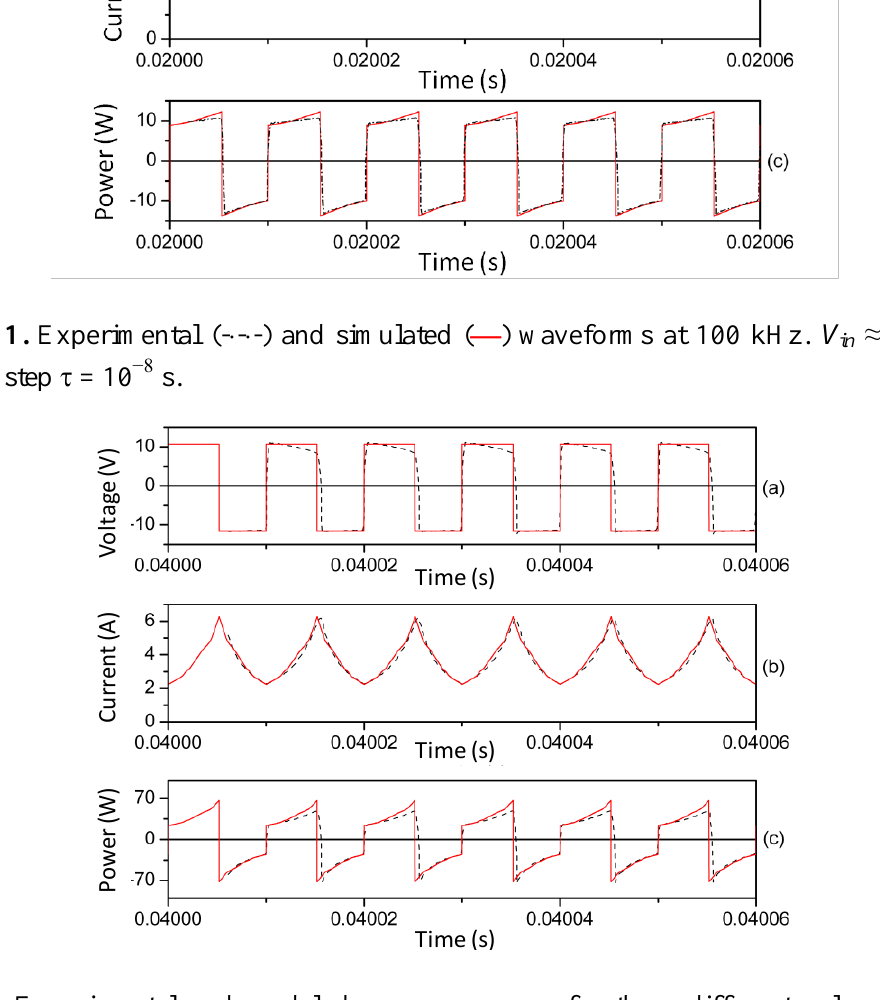
Figure 10. Experimental (-  -  -) and simulated (  ) waveforms at 100 kHz. V and time step  = 10 −8 s.